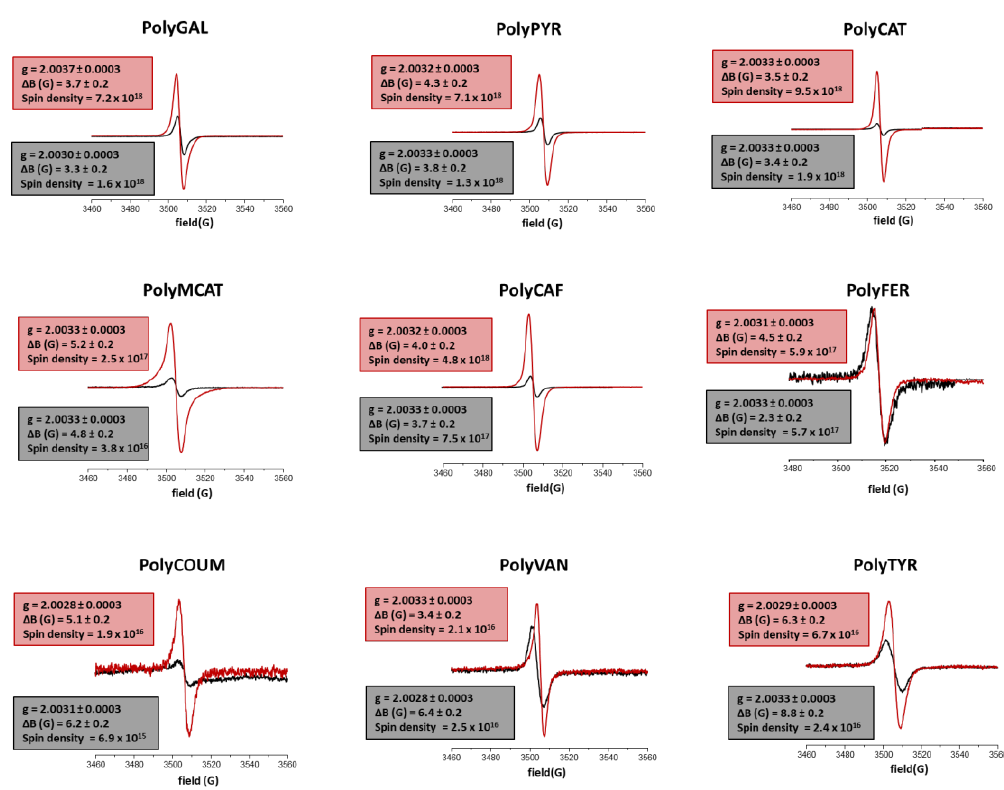
Figure 4. Solid-state EPR spectra of the enzymatically synthesized phenolic polymer before ( black traces ) and after ( red traces ) acid treatment.